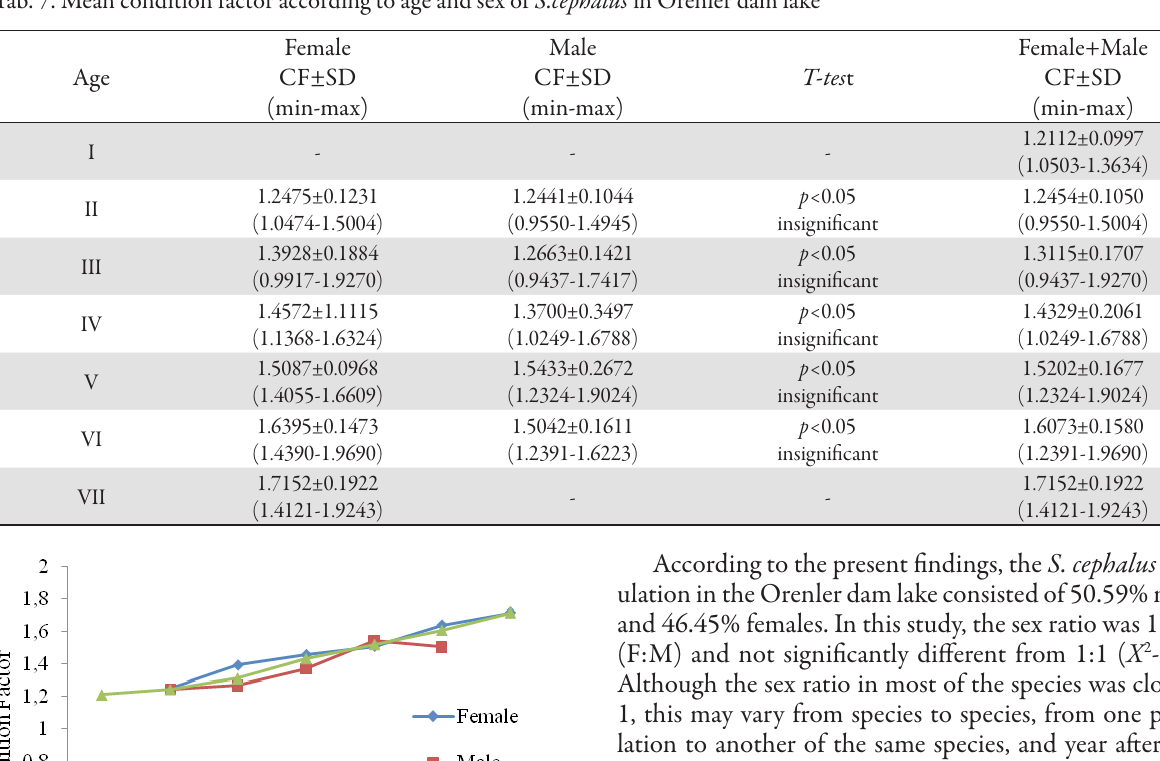
According to the present findings, the S. cephalus pop- ulation in the Orenler dam lake consisted of 50.59% males and 46.45% females. In this study, the sex ratio was 1:1.09 (F:M) and not significantly different from 1:1 ( X 2 -test).